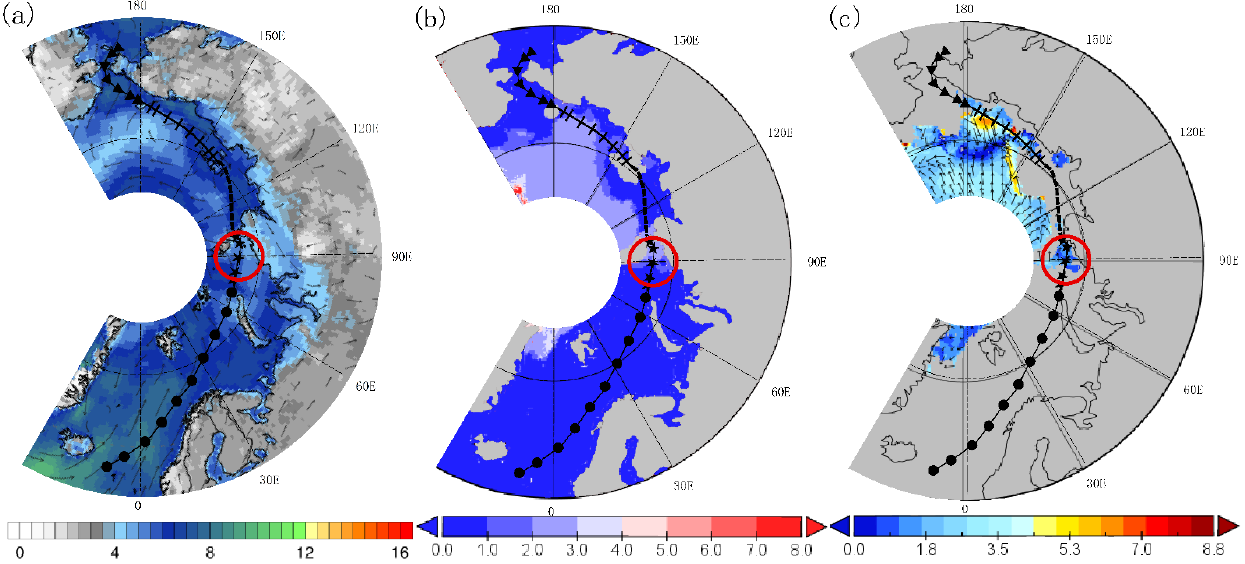
Figure 18. The average wind field ( a ), sea ice age ( b ) and sea ice movement ( c ) of the NEP in the Arctic in August 2013.